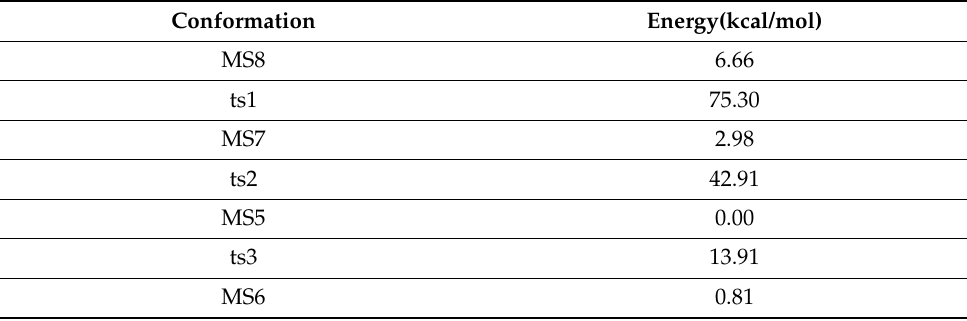
Table 5. Kinetic isomerization between cis-trans for KKI18.